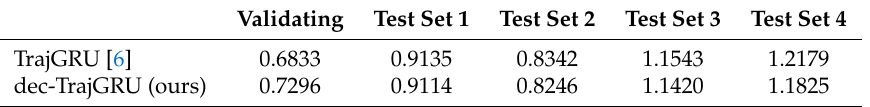
Table A3. Validating and testing MSE × 100 of TrajGRU and dec-TrajGRU models.